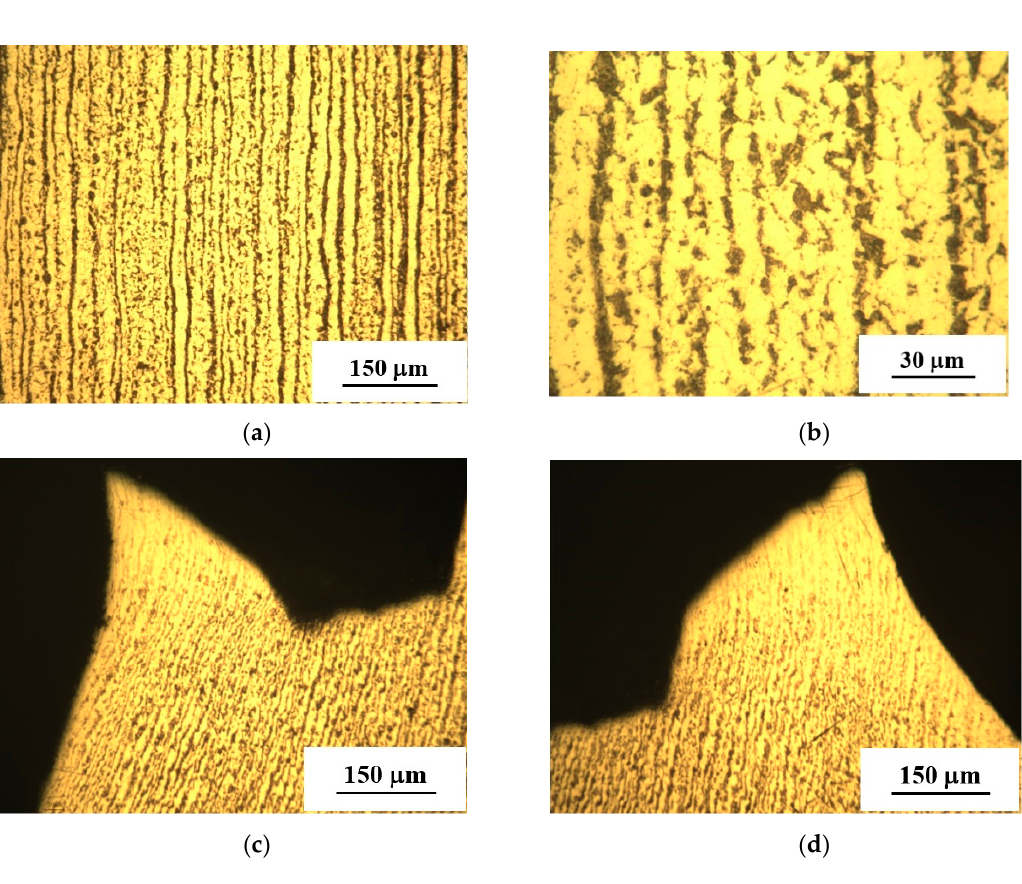
Figure 2. Microstructure of the fragment under investigation taken from the “Novopskov-Aksai-Mozdok” gas pipeline (Nevinnomysskaya CS): ferrite-pearlite structure with a striped morphology—( a ) (×100); ( b ) (×400); microstructure in the neck region of tensile stretched specimens (×100) ( c , d ).